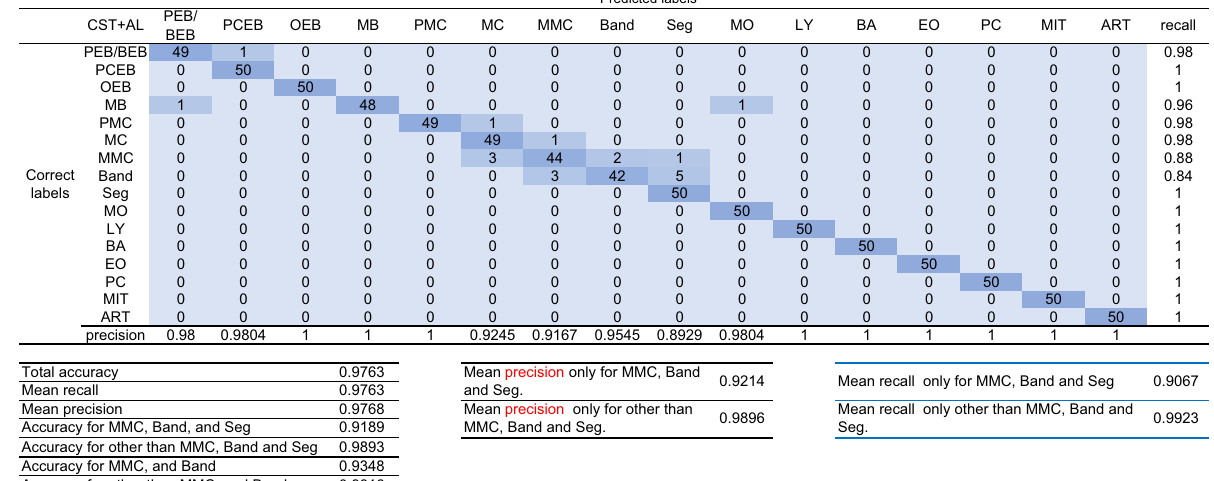
Figure 3. Confusion matrix for the prediction results by the model with the best accuracy. The confusion matrix was created with estimation results for the test data by the CST + AL classification model after the 25th training, which had the best accuracy. PEB/BEB, proerythroblasts/basophilic erythroblasts; PCEB, polychromatic erythroblasts; OEB, orthochromatic erythroblasts; MB, myeloblasts; PMC, promyelocytes; MC, myelocytes; MMC, metamyelocytes; Band, band neutrophils; Seg, segmented neutrophils; MO, monocytes; LY, lymphocytes; EO, eosinophils; BA, basophile/mastocyte; PC, plasma cell; MIT, mitotic-cell; ART, bare nucleus/